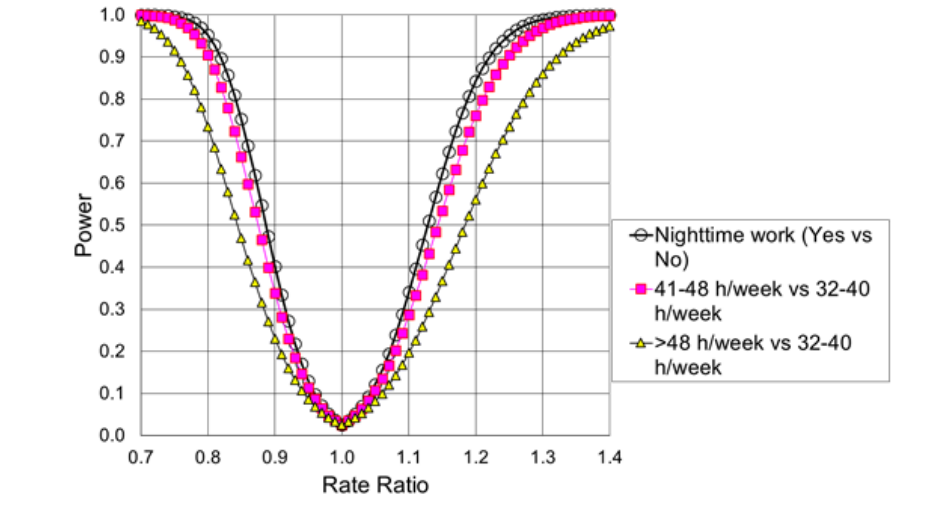
Figure 5. Power to detect main effects of night shift work and long working hours on the rates of new cases of psychiatric hospital treatment for mood disorders, anxiety disorders, or stress-related disorders, as a function of underlying rate ratios ( α =.05).